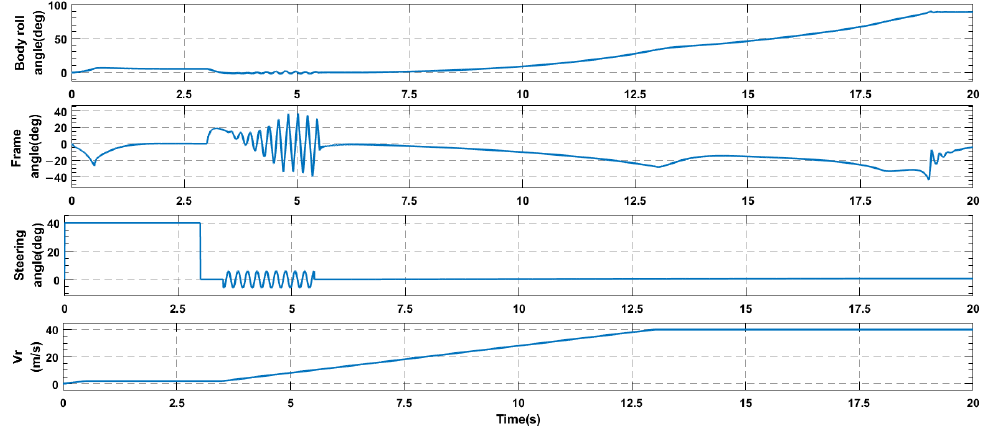
Figure 17. Simulation results: Self-balancing process of the car body under different wheel speeds and different steering angles.